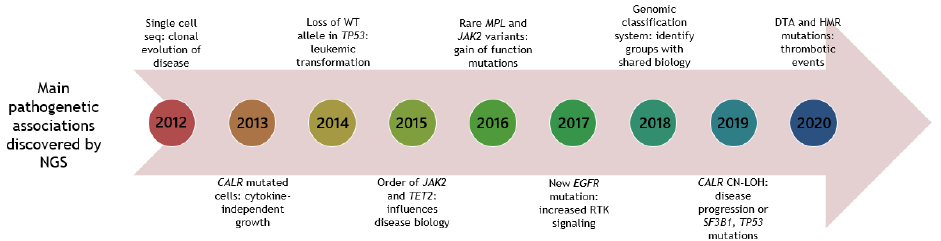
Figure 1. Timeline of NGS studies in patients with MPNs, unravelling main pathogenetic